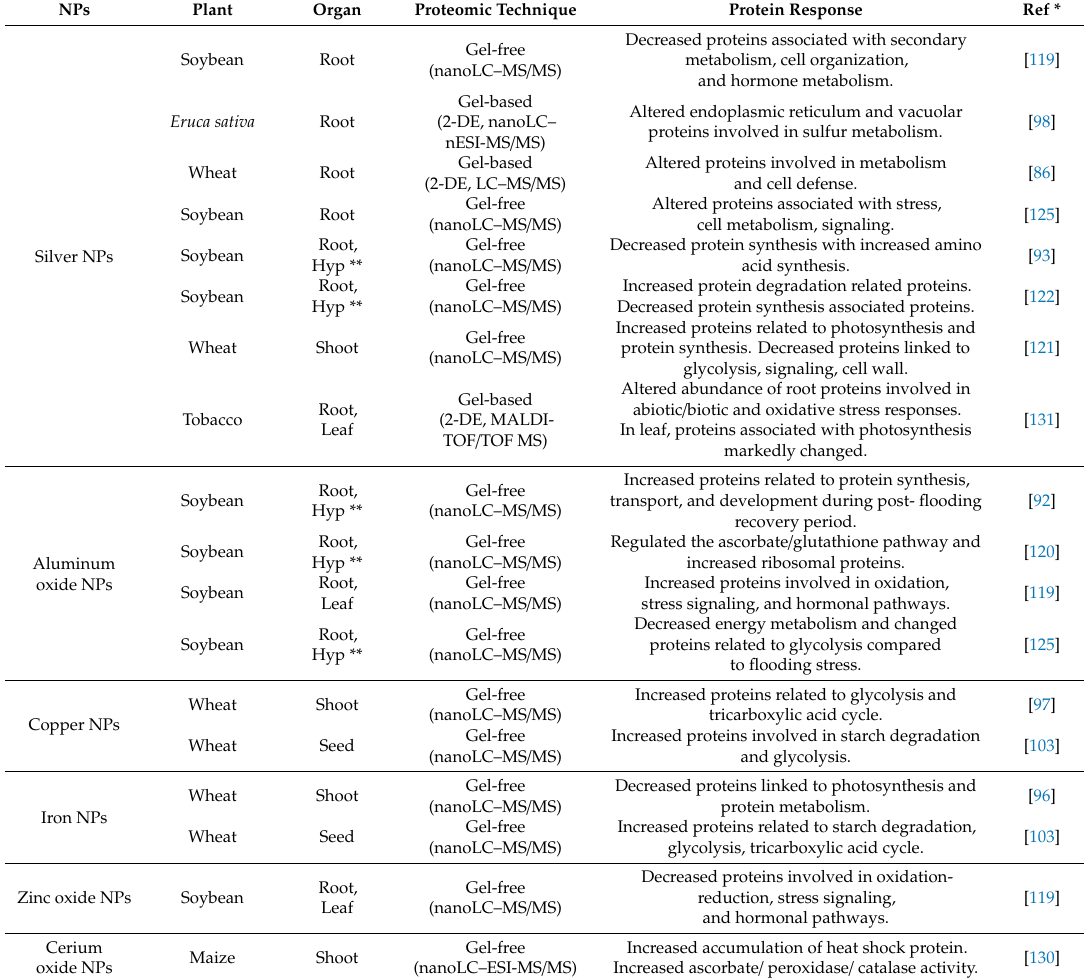
Table 3. Summary of proteomic analyses of various crops exposed to di ff erent